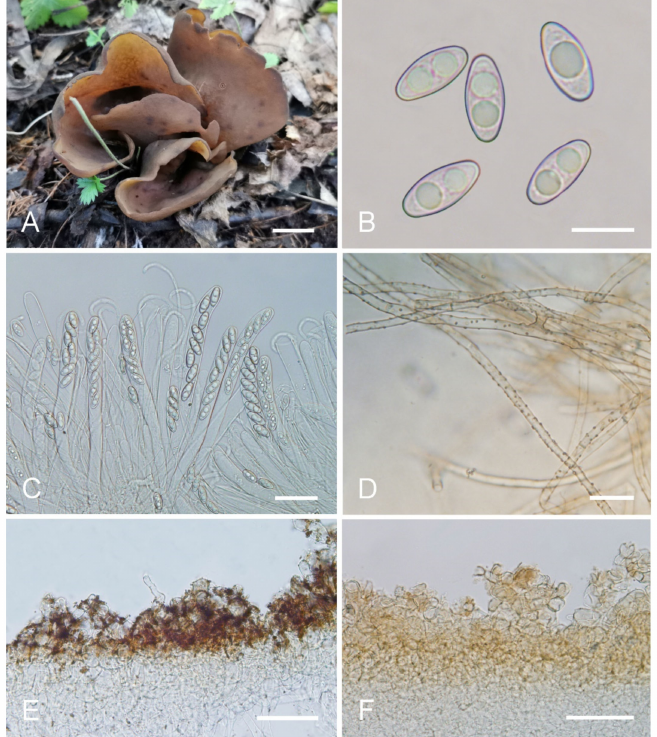
Figure 5. Otidea filiformis (BJTC C505) ( A ) apothecia, ( B ) ascospores, ( C ) asci and paraphyses, ( D ) basal mycelium, ( E ) ectal excipulum in water, and ( F ) ectal excipulum in KOH. Scale bars: ( A ) = 1 cm, ( B ) = 10 µ m, ( C ) = 30 µ m, ( D ) = 20 µ m, ( E , F ) = 50 µ m. MycoBank: